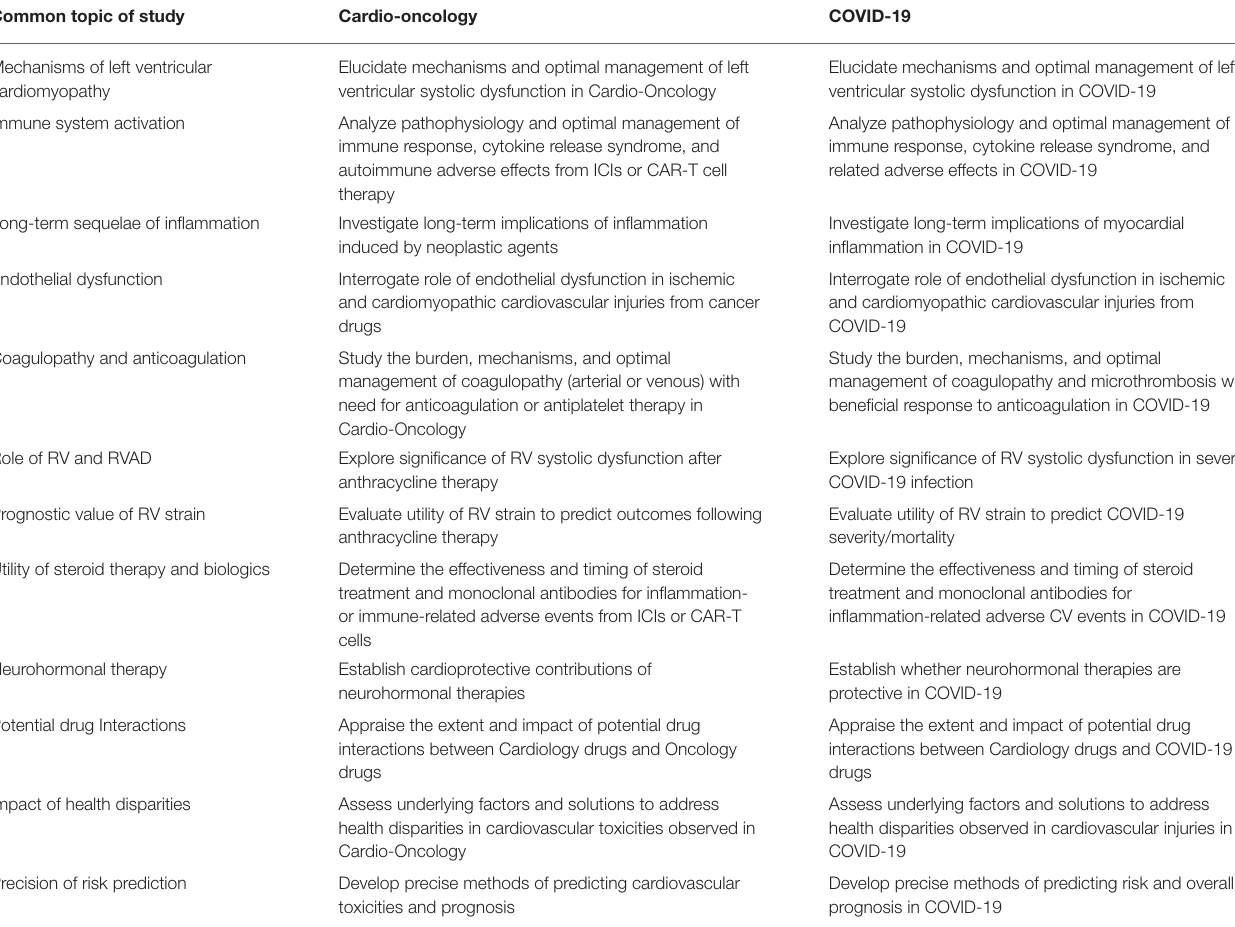
TABLE 1 | Mechanisms, concepts, and paradigms: commonalities in toxicity, pathophysiology, and pharmacology of cardio-oncology and COVID-19. Common topic of